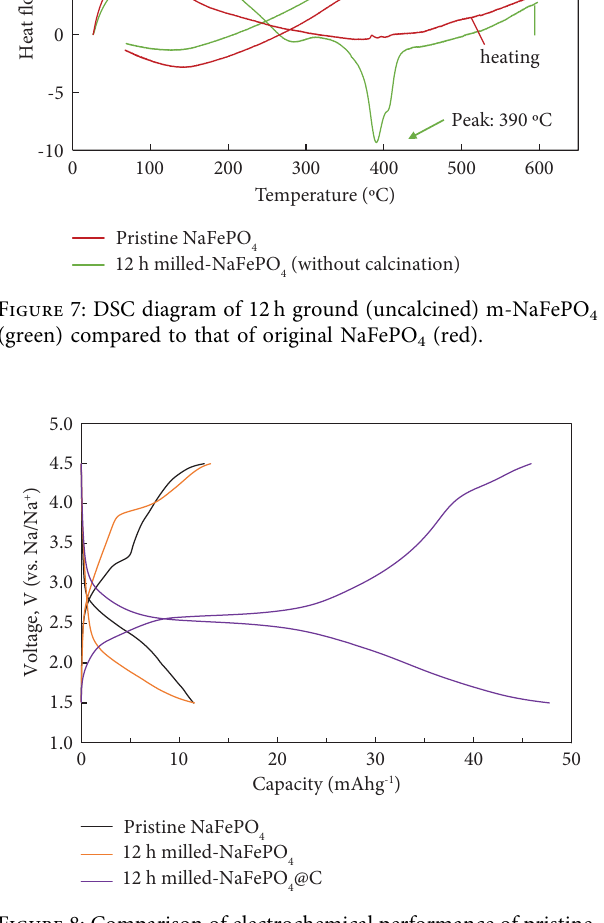
Figure 8: Comparison of electrochemical performance of pristine, milled, and milled-coated NaFePO 4 materials (cycle number